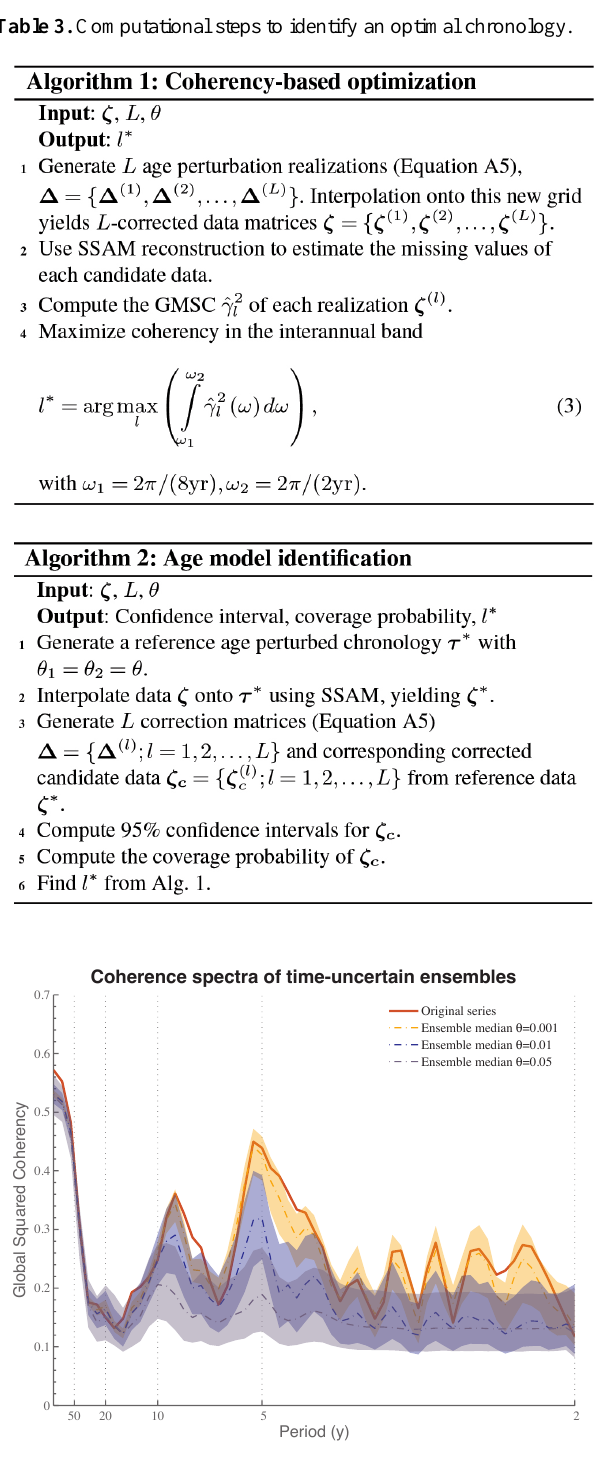
Fig. 7. Global coherence spectra for time-uncertain ensembles gen- erated with θ 1 = θ 2 = 0 . 001 (orange), θ 1 = θ 2 = 0 . 01 (dark blue) and θ 1 = θ 2 = 0 . 05 (gray). The ensemble medians are illustrated in dashed lines, and their corresponding colored patches represent the ensemble 95% CIs. The thick red curve is the coherence spectrum of the error-free time series.